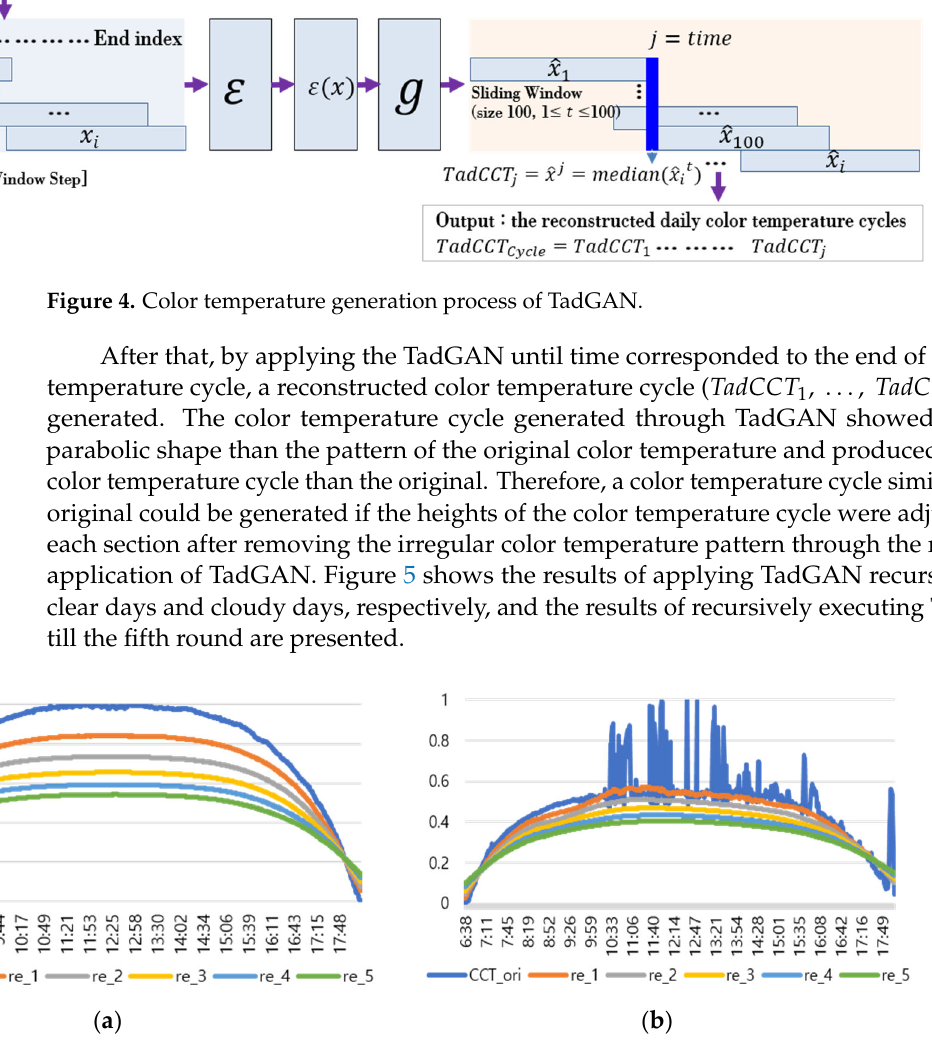
Figure 5. Experiment 2 by applying TadGAN: Generation of the TadGAN-based color temperature cycle. ( a ) Clear day (on 18 March 2020, 5 iterations of recursive model); ( b ) Cloudy day (on 14 September 2020, 5 iterations of recursive model).